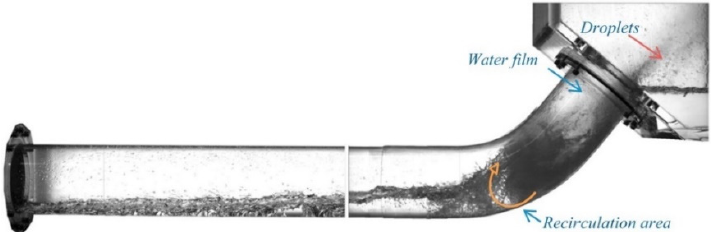
= 0.105 (Issa and Juan [69]). L